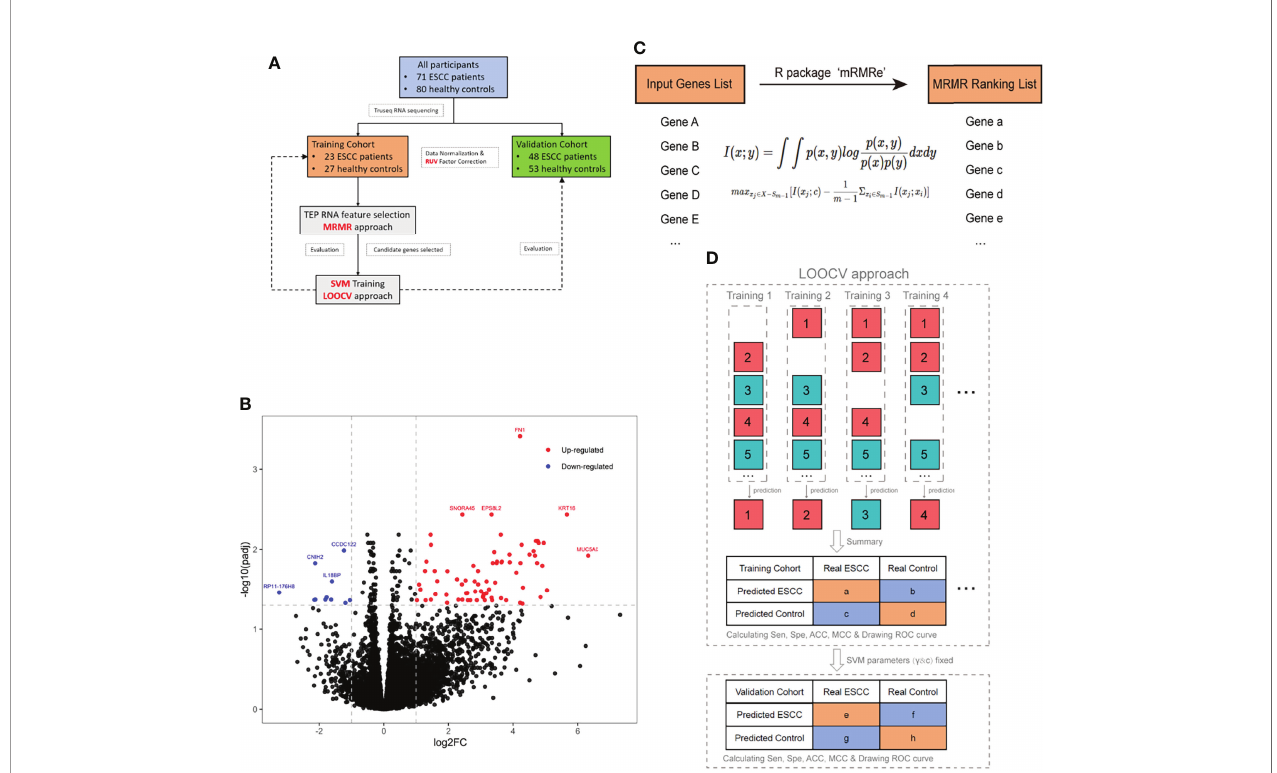
FIGURE 1 | Schematic representation of analysis pipeline and core methods used in this study. (A) Flowchart of participant distribution and data processing procedure. (B) A logistic regression model was used to perform differential expression analysis between ESCC and the control group. Seventy-four red- and 11 blue- colored dots indicated upregulated genes and downregulated genes in ESCC, respectively (|fold change| >2 and p adj < 0.05). FN1, KRT16, EPS8L2, SNORA45 , and MUC5AC were most signi fi cantly upregulated and CCDC122, CNIH2, IL18BP , and RP11-176H8 were most signi fi cantly downregulated. (C) Schematic representation of the MRMR approach. Top 200 differentially expressed genes input into R-package mRMRe to generate a gene-ranking list for features selection with maximum relevance and minimum redundancy. (D) Schematic representation of the SVM/LOOCV model training and validation. In the training cohort, the SVM algorithm was trained to get optimal parameters of gamma and cost by all samples minus one, while the remaining sample was used for blind classi fi cation until every sample has been predicted. The search range for gamma and cost parameters of SVM algorithm were 10^(-10:1) and 2^(1:10) respectively. After LOOCV approach was completed in the training cohort, gamma and cost parameters were fi xed to do binary classi fi cation in the validation cohort. For both cohorts, we got a confusion matrix and ROC curve of diagnosis for ESCC. ACC, accuracy; ESCC, esophageal squamous cell carcinoma; LOOCV, leave-one-out cross-validation; MCC, Matthews correlation coef fi cient; MRMR, minimal redundancy and maximal relevance; SVM, support vector machine; ROC, receiver operative